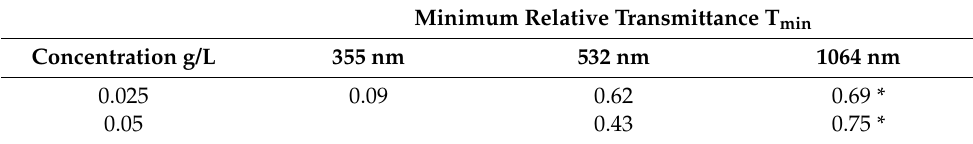
Figure 3. Normalized transmittance Tn for the 0.025 g/L-concentrated sample. The experimental un- certainty on the measured input and output energies is 2.5%, 5% on the normalized transmittance Tn. Table 1. Obtained minimum transmittances at different